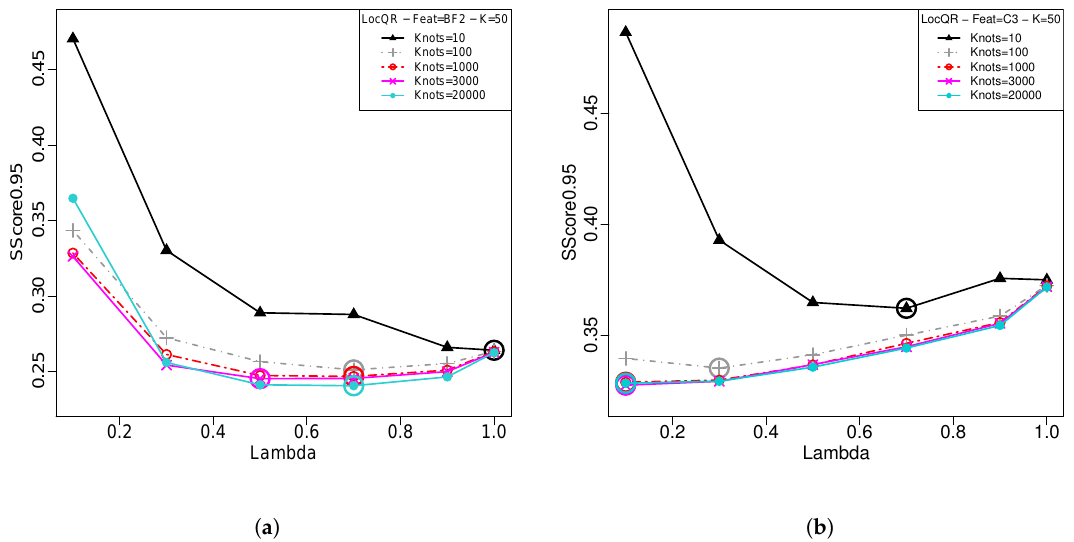
Figure 4. Skill score diagrams of Local Quantile Regression (LocQR) models as a function of lambda and number of knots. ( a ) BF2 feature set; ( b ) C3 feature set.